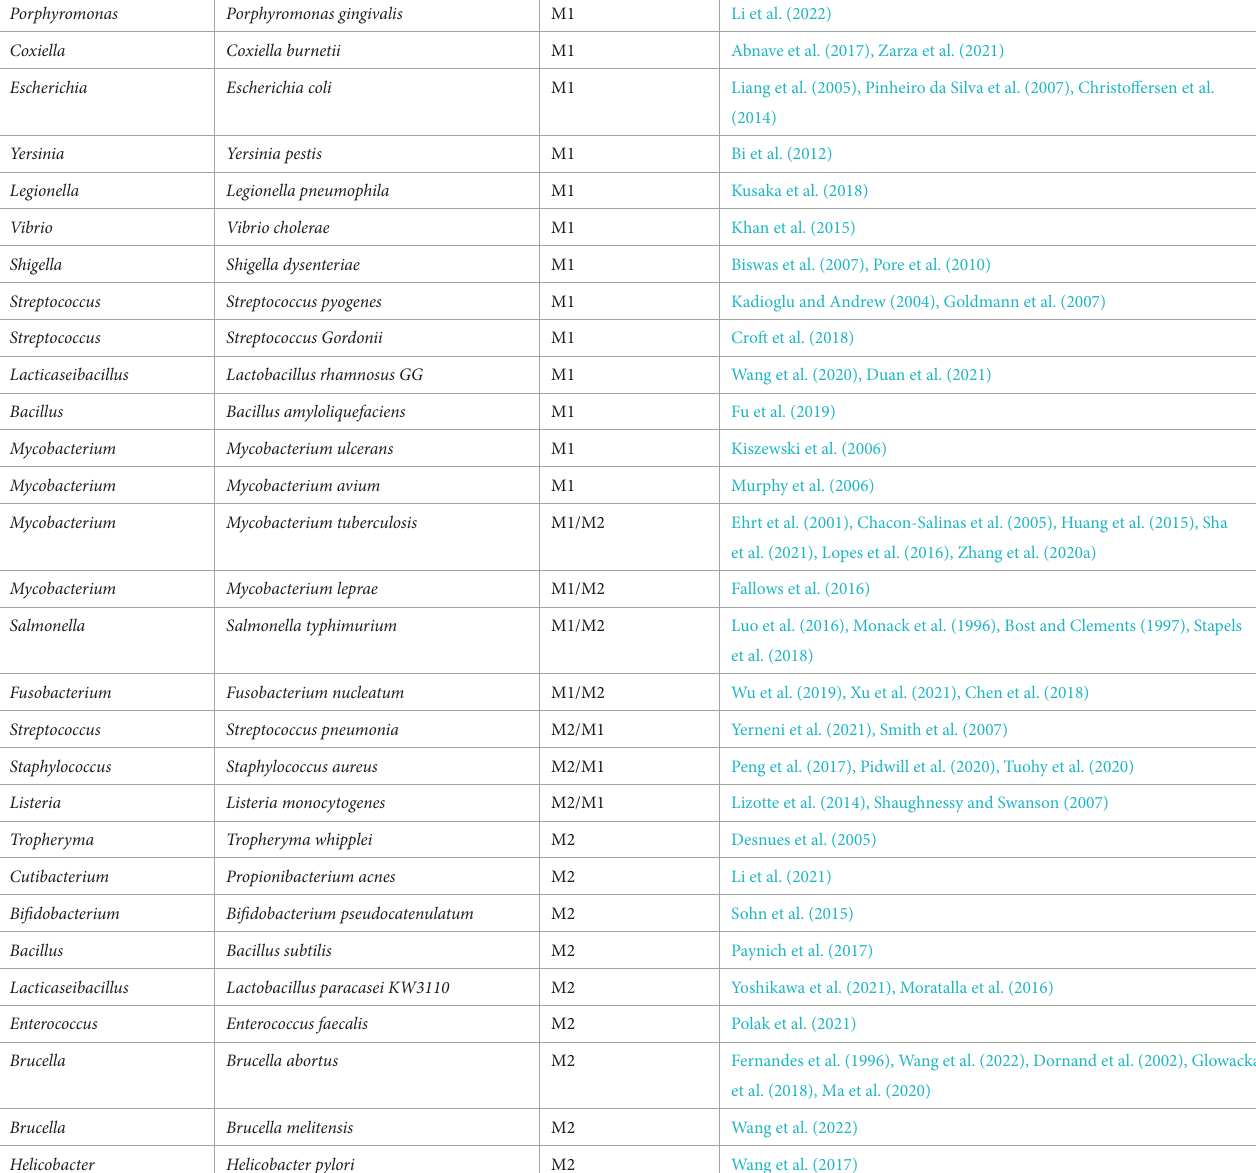
TABLE 2 An aggregate list of bacterial-driven macrophage polarization that has been studied is currently